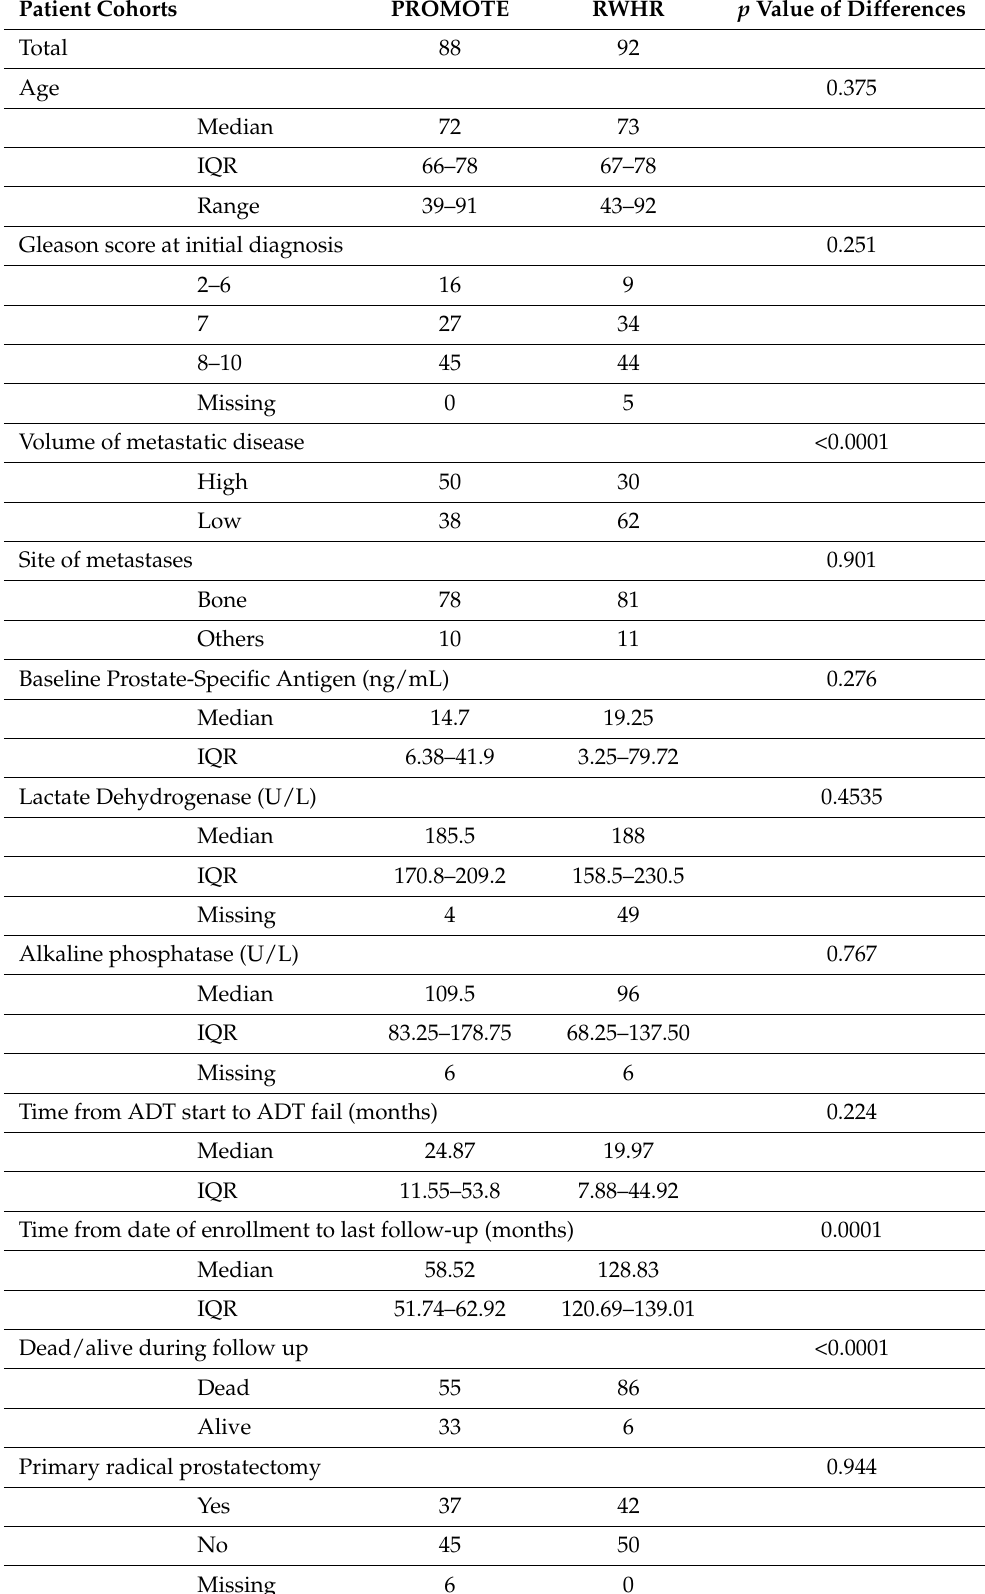
Table 1. Clinical characteristics of the PROMOTE and RWHR